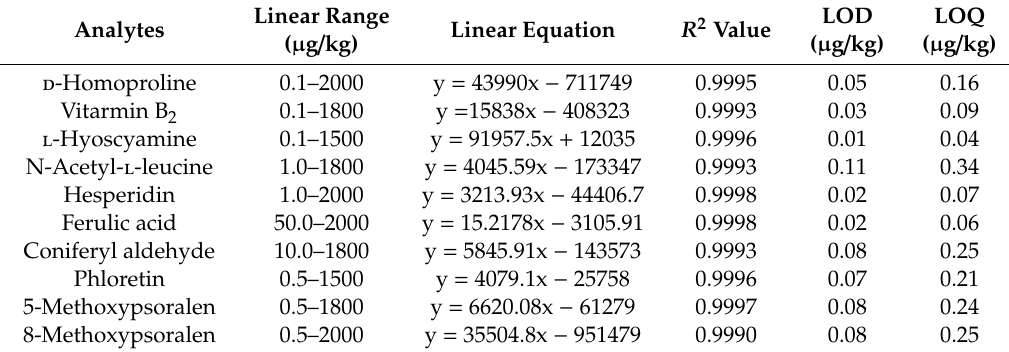
Table 2. Linear equation, determination coe ffi cients ( R 2 ), LODs and LOQs of target compounds.